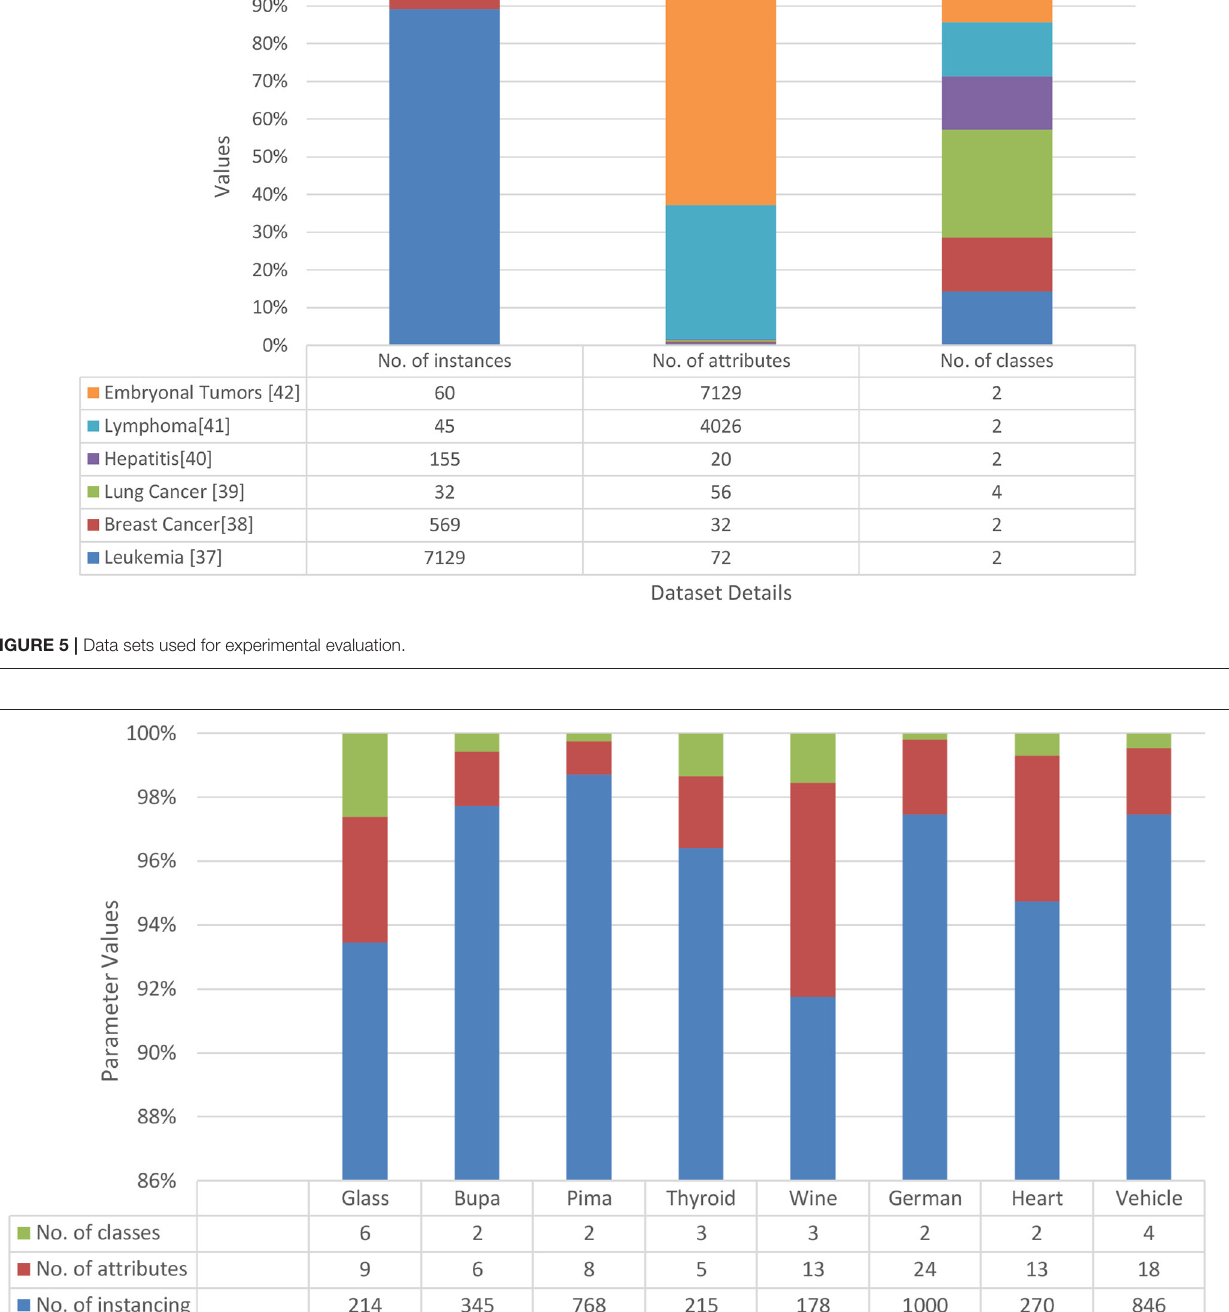
product of the f ( ξ i W t ) is evaluated using Equation